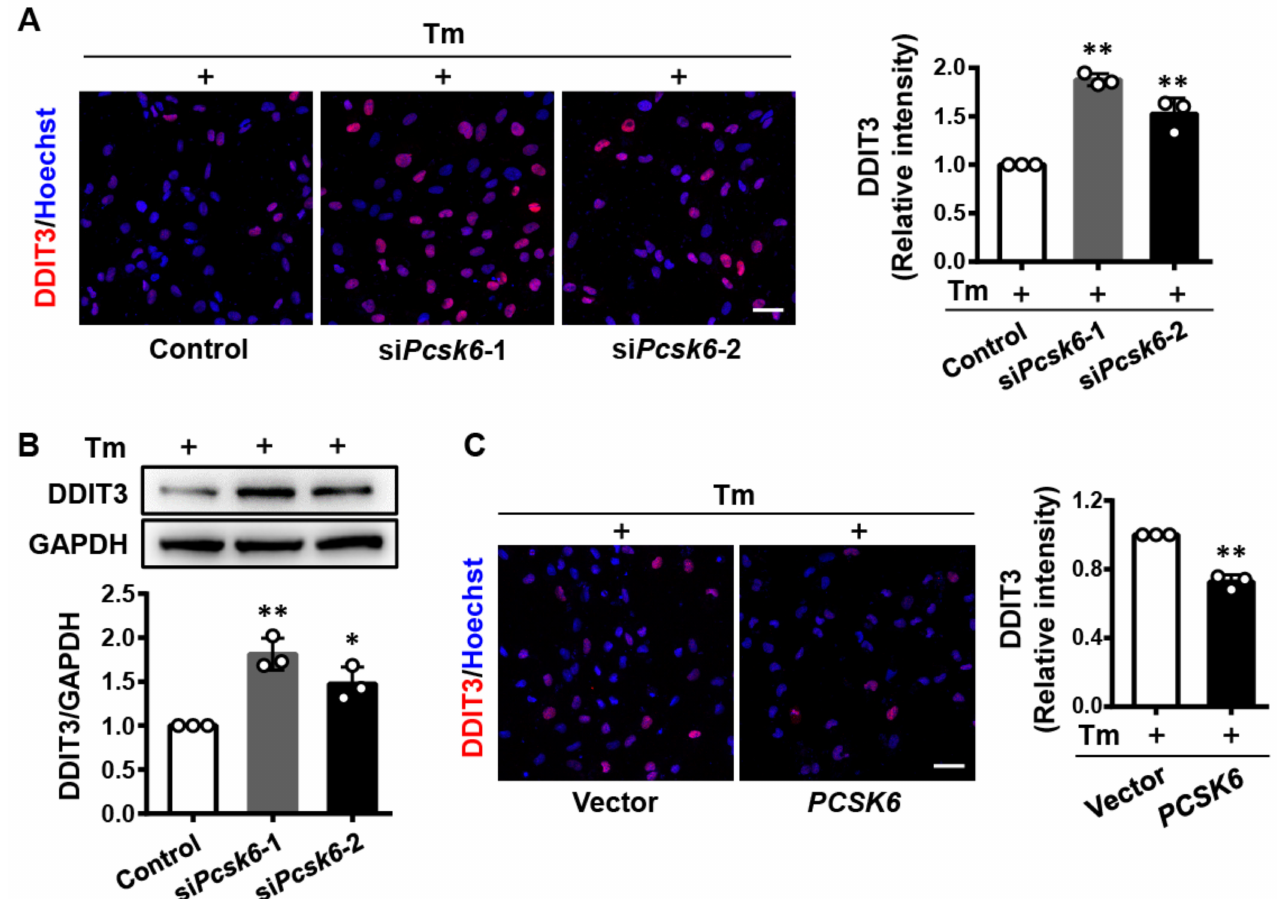
Figure 7. PCSK6 in the regulation of DDIT3 expression in Tunicamycin (Tm)-treated H9c2 cells. ( A ) Immunofluorescent staining of DDIT3 protein (red) and nuclei (blue) in H9c2 cells treated with two sets of si Pcsk6 and Tm (1 µ g/mL). Scale bar: 40 µ m. Relative levels were analyzed based on mean fluorescence intensity. ( B ) Western blot analysis of DDIT3 protein expression in Pcsk6 - knockdown H9c2 cells treated with Tm (1 µ g/mL). ( C ) PCSK6 -overexpressed H9c2 cells treated with Tm (1 µ g/mL) were immunostained for DDIT3 (red) and nuclei (blue). Scale bar: 40 µ m. Values are mean ± S.D. * p < 0.05, ** p < 0.01 vs. Control or